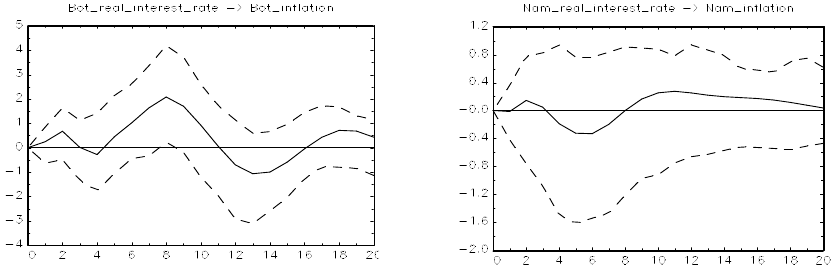
FIGURE 5: Impulse response of the real effective exchange rate on inflation Source: Authors' calculations